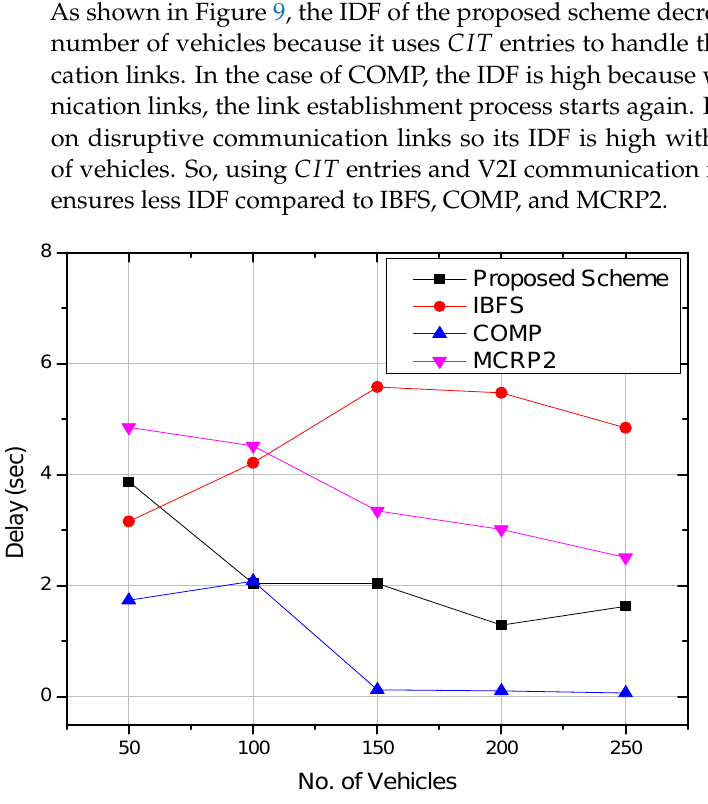
Figure 8. Average Communication Delay of Multihead Selection